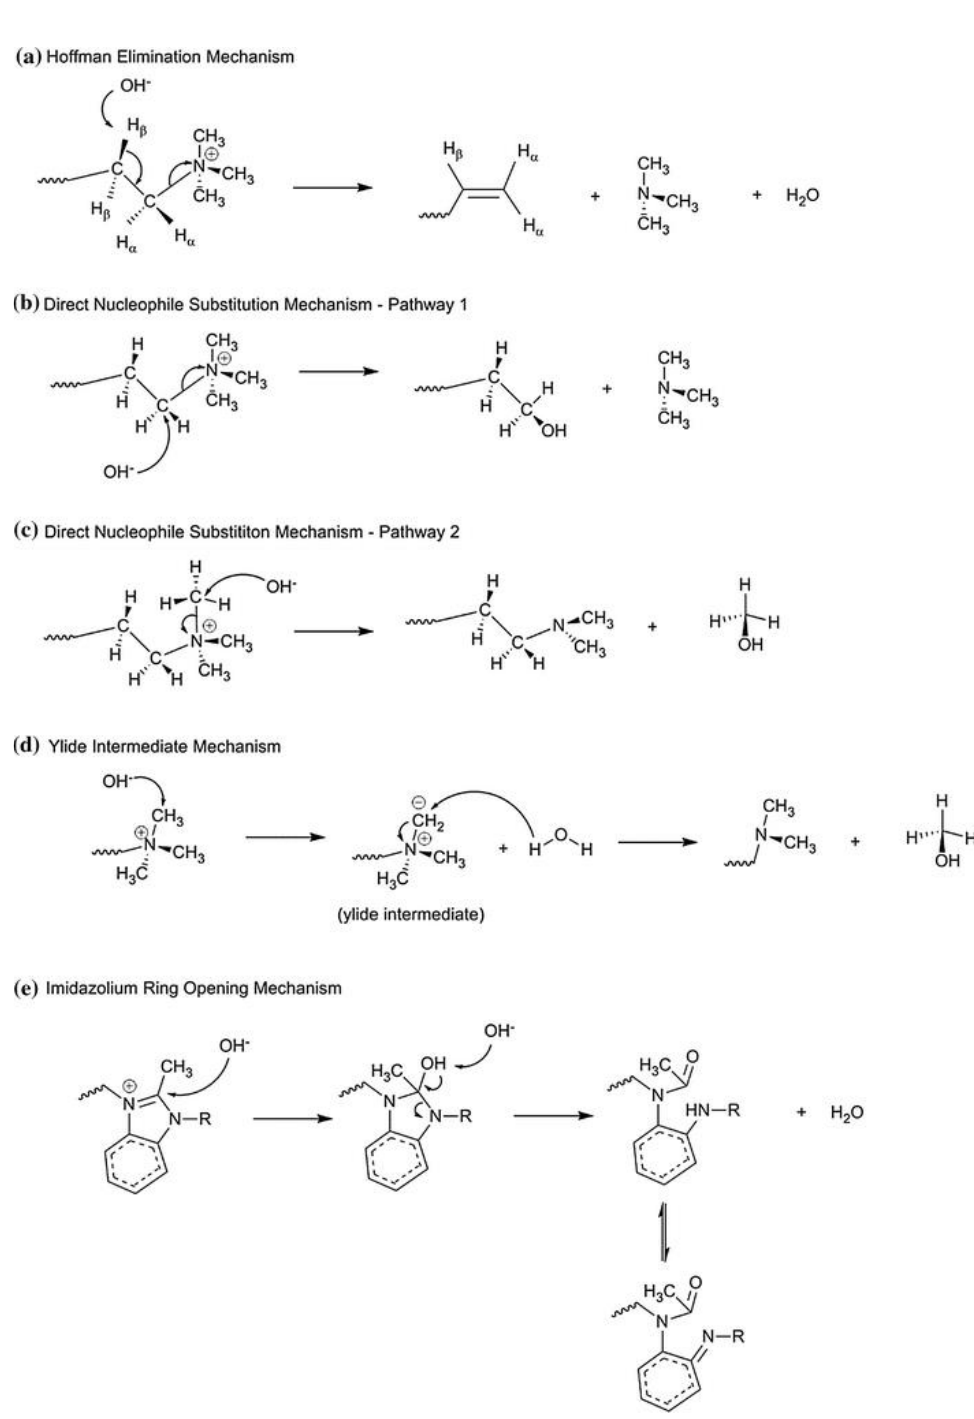
Figure 5. Scheme of the mechanisms of degradation of ammonium bases. Reproduced with permis- sion from Ref. [59] under the terms of the Creative Commons Attribution 4.0 International License (http://creativecommons.org/licenses/by/4.0/ (accessed on 26 December 2022)). Copyright © 2018, the author(s).